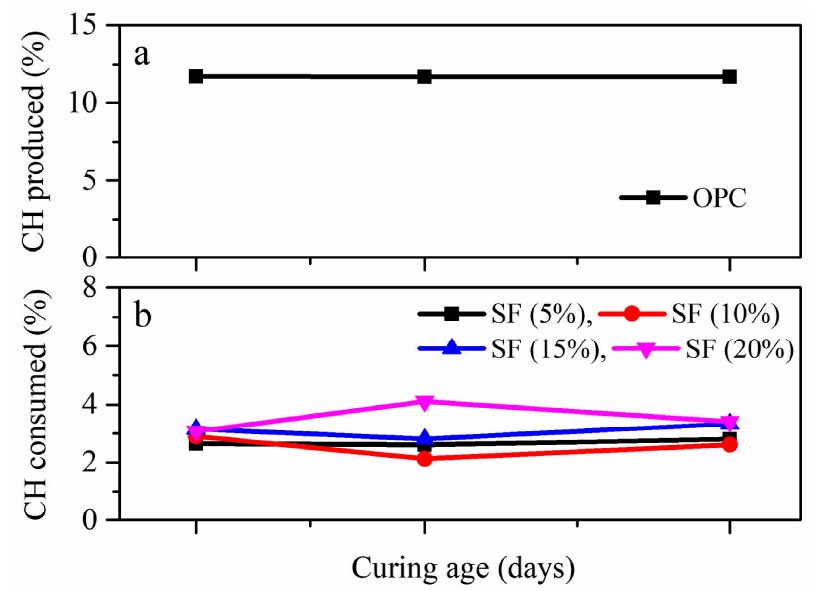
Figure 1. The amount of CH produced by ( a ) OPC and ( b ) consumed by silica fume at different percentages of cement replacement [6]. percentages of cement replacement